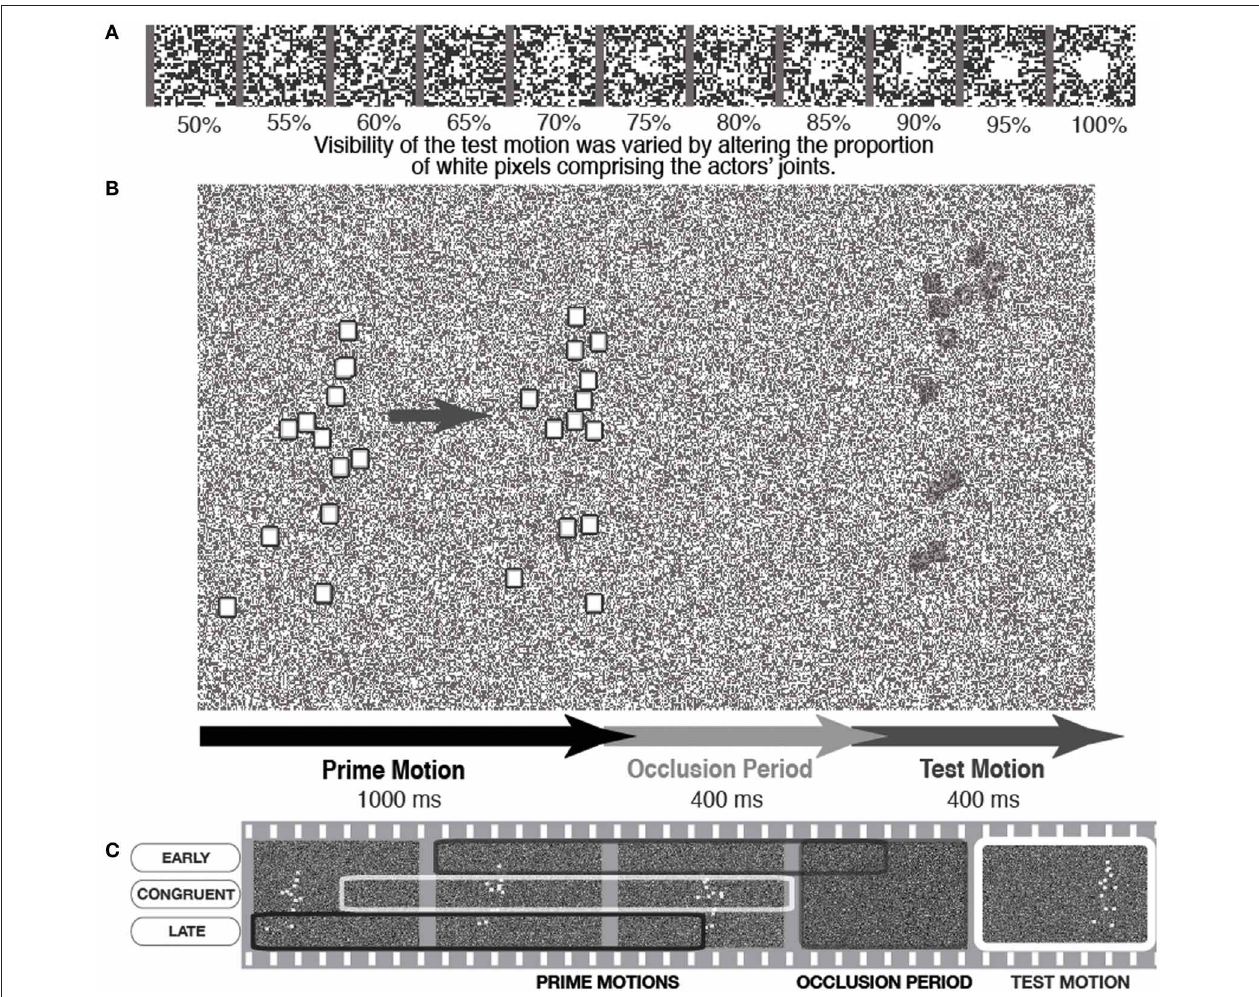
FIGURE 2 | A schematic illustration of a trial in which the PLA was presented with variable visibility against the background. (A) Shows how varying white pixel ratio in the actor’s joints increases visibility against the noise background, (B) shows a basic trial sequence, and (C) depicts a schematic showing how different sections of the action were shown as the